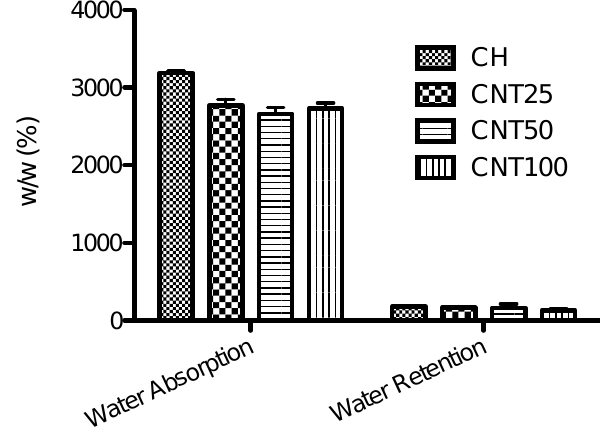
Figure 1. Water uptake and retention ability of chitosan, CNT25, CNT50 and CNT100 composite hydrogels after 24 h. The values are mean ±